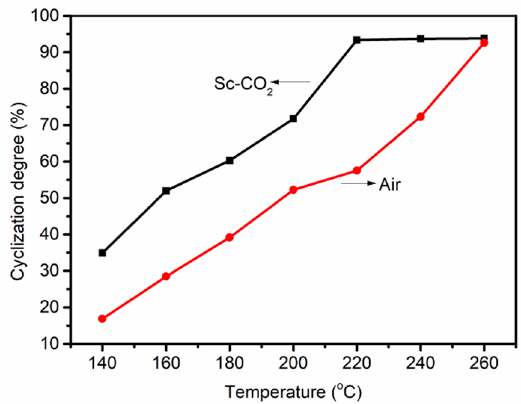
Figure 9. Cyclization degree of PAN fibers treated at different temperatures in air and Sc-SO 2 .